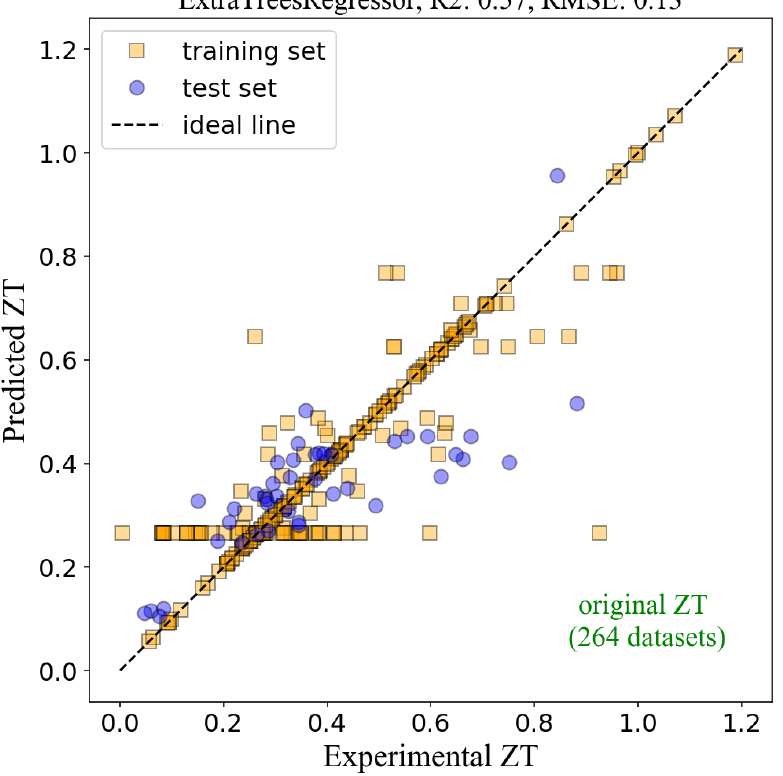
Figure 2. The plot of the Predicted ZT versus the Experimental ZT from the ML model using ET regressor. The total datasets of 264 datasets were used, resulting in the R 2 of 0.57 and the RMSE of 0.13.